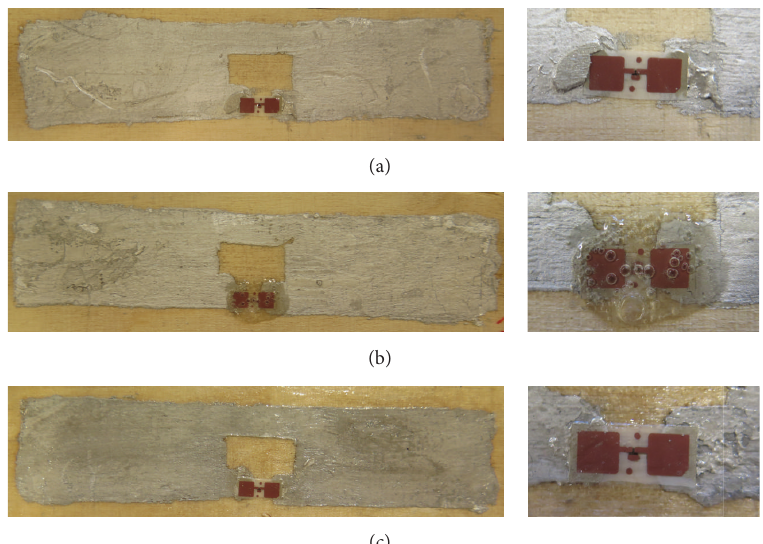
Figure 2: Noncoated tag and a close-up of the IC-area (a), IC-coated tag and a close-up of the IC-area (b), and all-coated tag and a close-up of the IC-area (c).